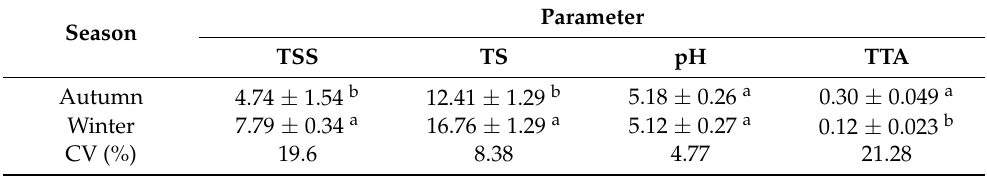
Table 5. Mean values ± standard deviation of the TSS ( ◦ Brix), TS (%), pH, and TTA (g citric acid 100 g − 1 of fresh sample) parameters of Pereskia aculeata Mill. leaves in the autumn and winter seasons. Parameter Season TSS TS pH TTA